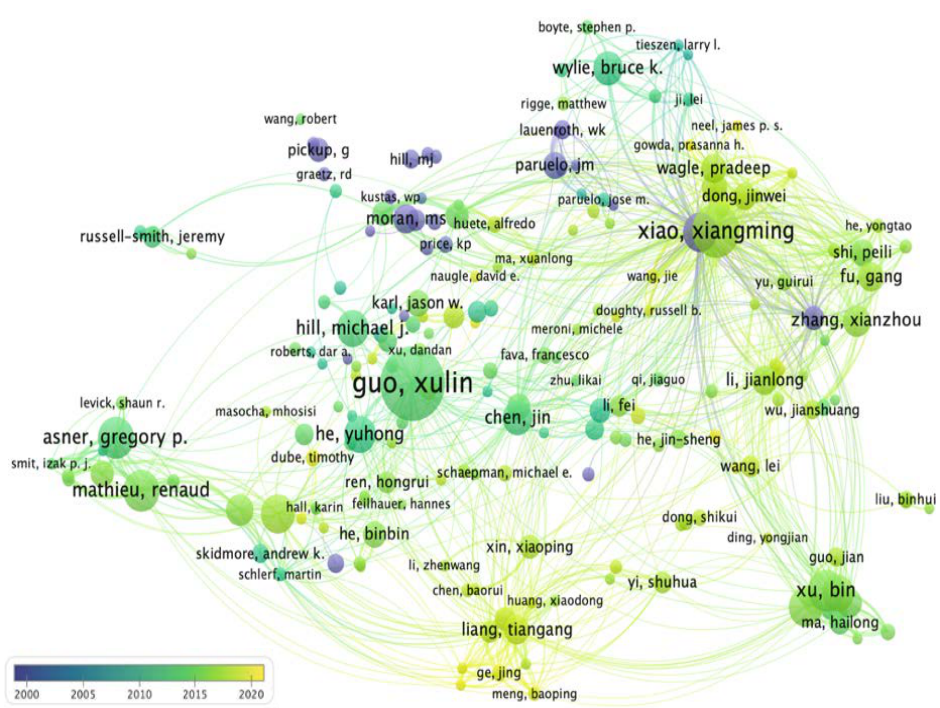
Figure 5. Evolution of authors’ network based on the co-occurrence method on GRS research from 1980 to 2020.